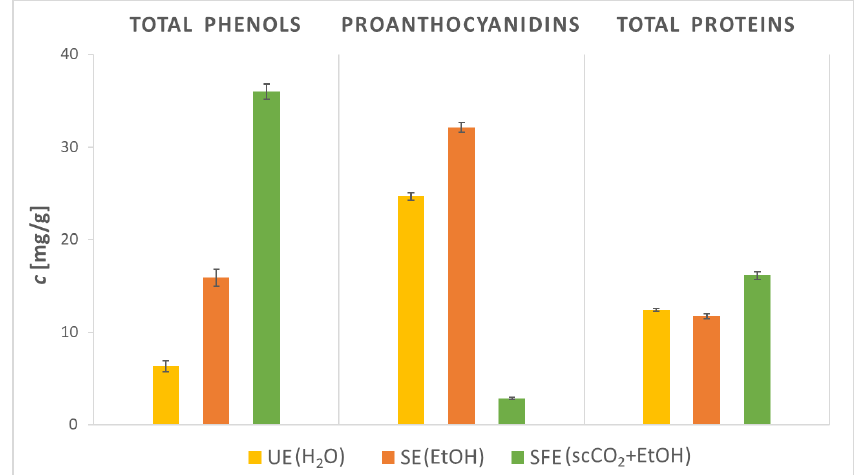
Figure 2. Content of total phenols (TPC), proanthocyanidins (PAC), and total proteins (PC) in AS extracts obtained by ultrasonic extraction (UE; solvent H 2 O), Soxhlet extraction (SE; solvent EtOH), and supercritical fluid extraction (SFE; solvent scCO 2 , co-solvent EtOH).